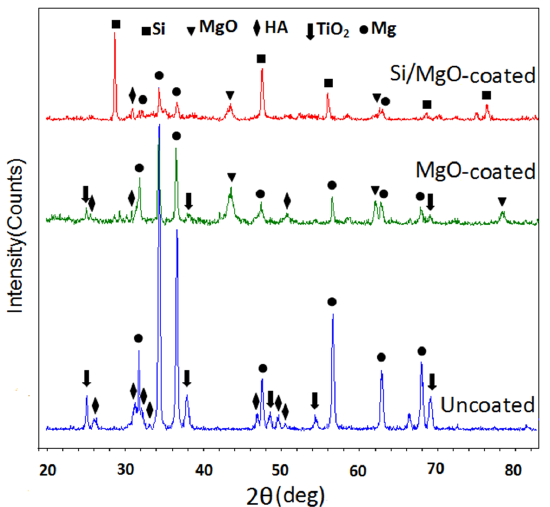
Figure 2. X ‐ ray diffraction (XRD) patterns of the uncoated, MgO ‐ coated and Si/MgO ‐ coated after the milling ‐ cold pressing ‐ sintering process. milling-cold pressing-sintering